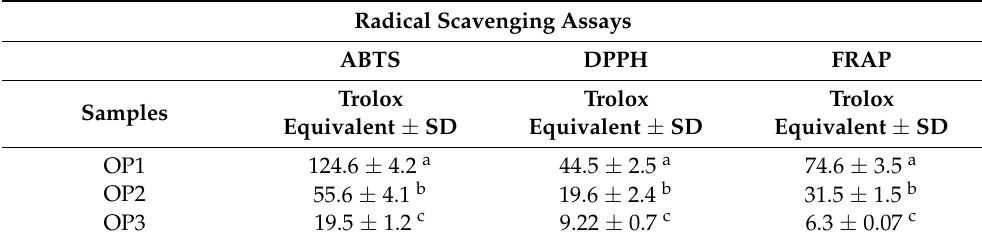
Table 4. The radical scavenging activity of methanolic extracts obtained from the three crude OP1, OP2 and OP3 batches. Values are reported as Trolox equivalent ( µ g TE/mg dry extract). Radical Scavenging Assays